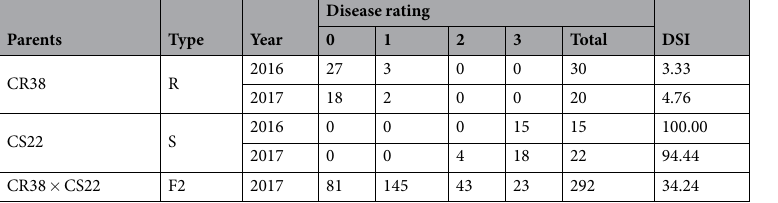
. DSI(%) 100 (rating class) (#plant in rating class) × (total # plants in treatment) 3